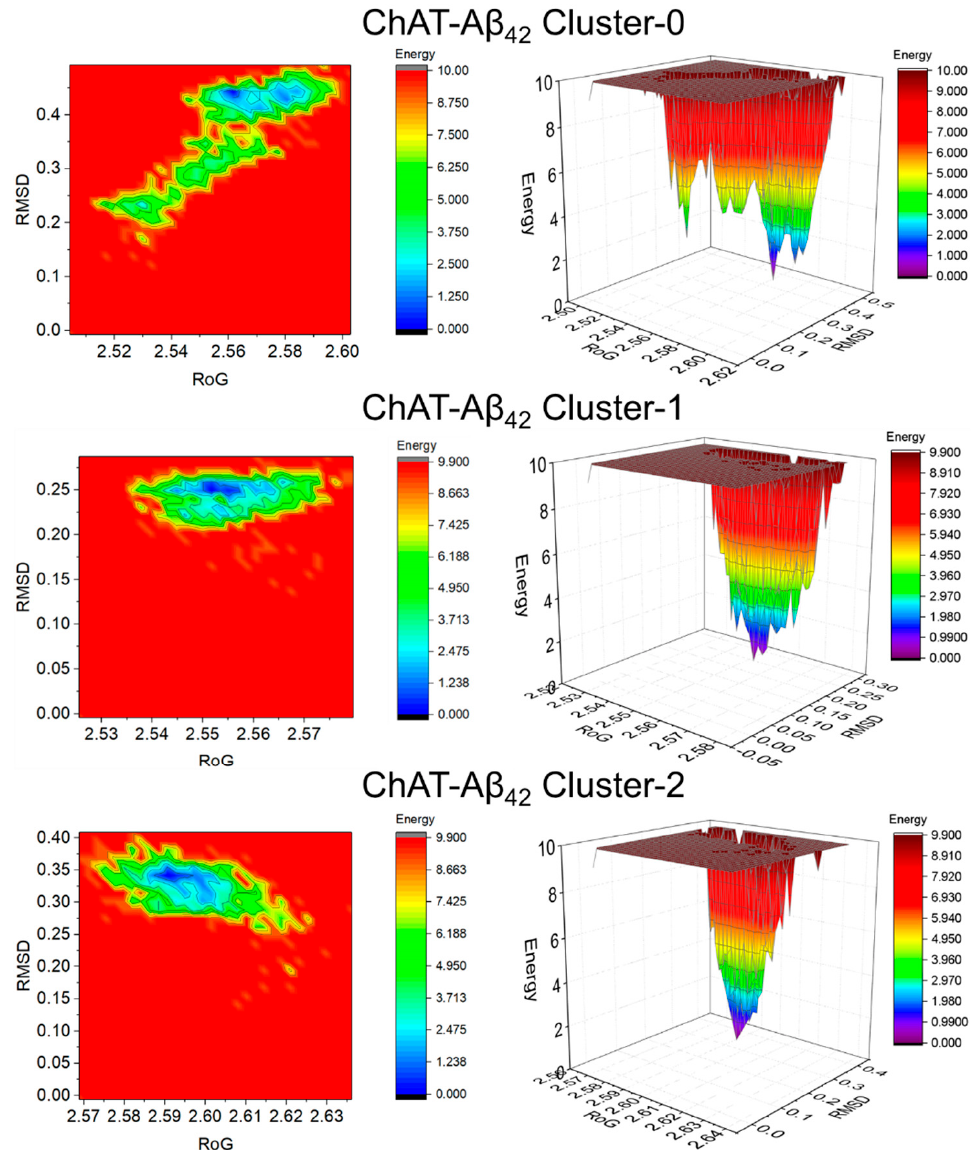
Figure 8. The 2D and 3D free-energy landscape diagrams as a function of RMSD and RoG as the two reaction coordinates of ChAT-A β 42 clusters. The folding funnel of the complex system forms a single narrow funnel which indicates a stable folding process. The 2D contour plots and the 3D projections were plotted using OriginPro 2017 software (OriginLab Inc., Northampton, MA, USA). The free energy is given in kJ/mol and indicated by color. RMSD: Root mean square deviation, RoG: Radius of